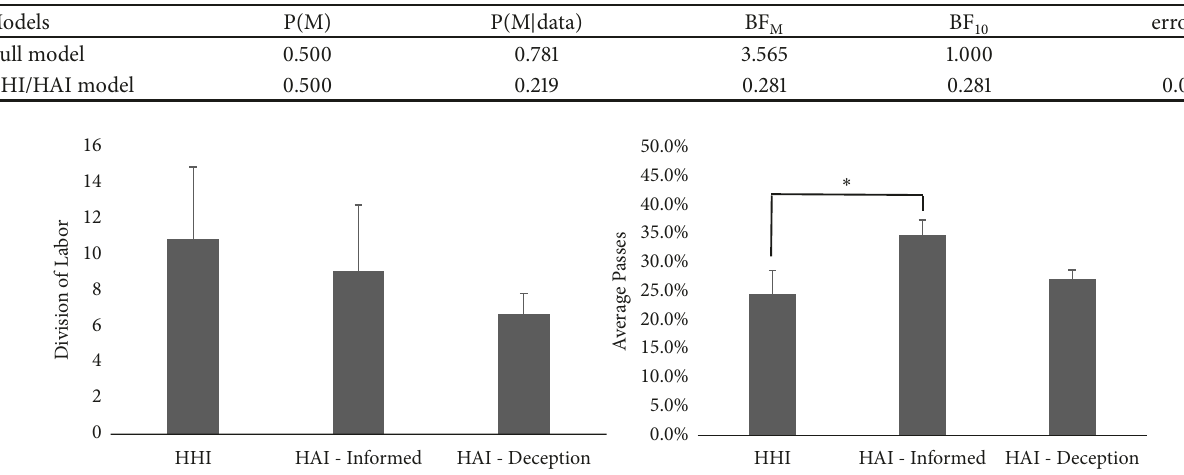
Table 1: Model comparison – Division of labor.